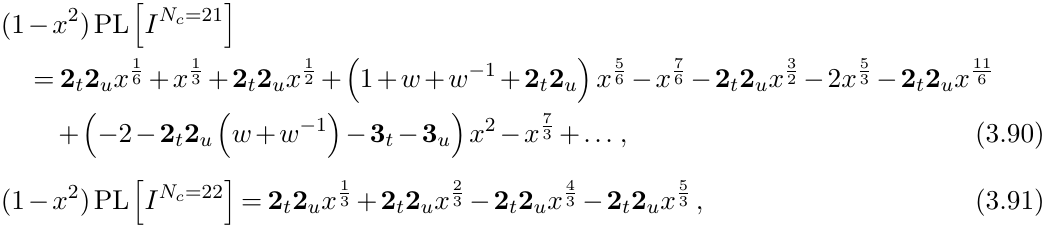
(cid:17) 2 x 5 6 − x 7 6 − 2 t u